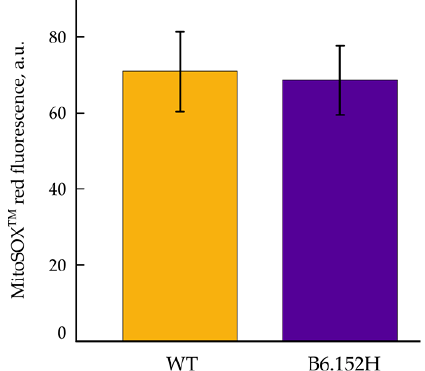
Figure 5. Measurements of superoxide production in primary hippocampal neurons. Basal MitoSOX fluorescence. WT, yellow, and B5.152H, purple, hippocampal neurons loaded with 200 nM MitoSOX™. The result is expressed as the average fluorescence for 8 WT and 6 B6.152H coverslips, re- spectively, with multiple neurons, derived from at least three independent preparations. For p ≤ 0.05, the differences between the two genotypes were not statistically significant. Columns represent mean value plus/minus SD.